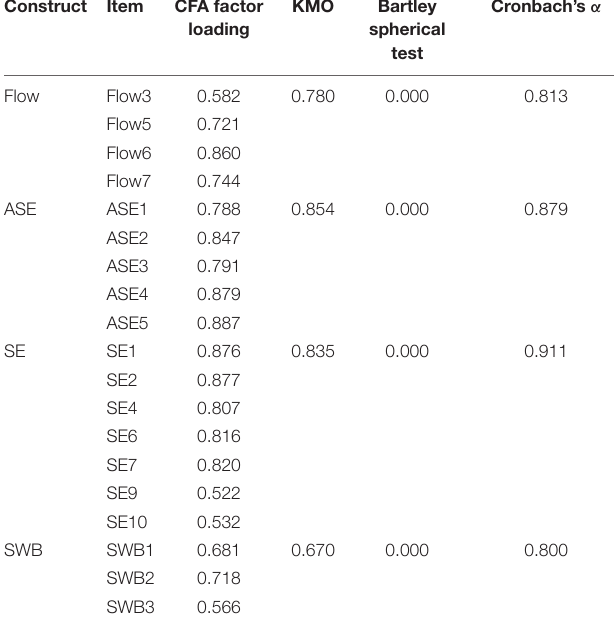
TABLE 3 | Test of construct validity and